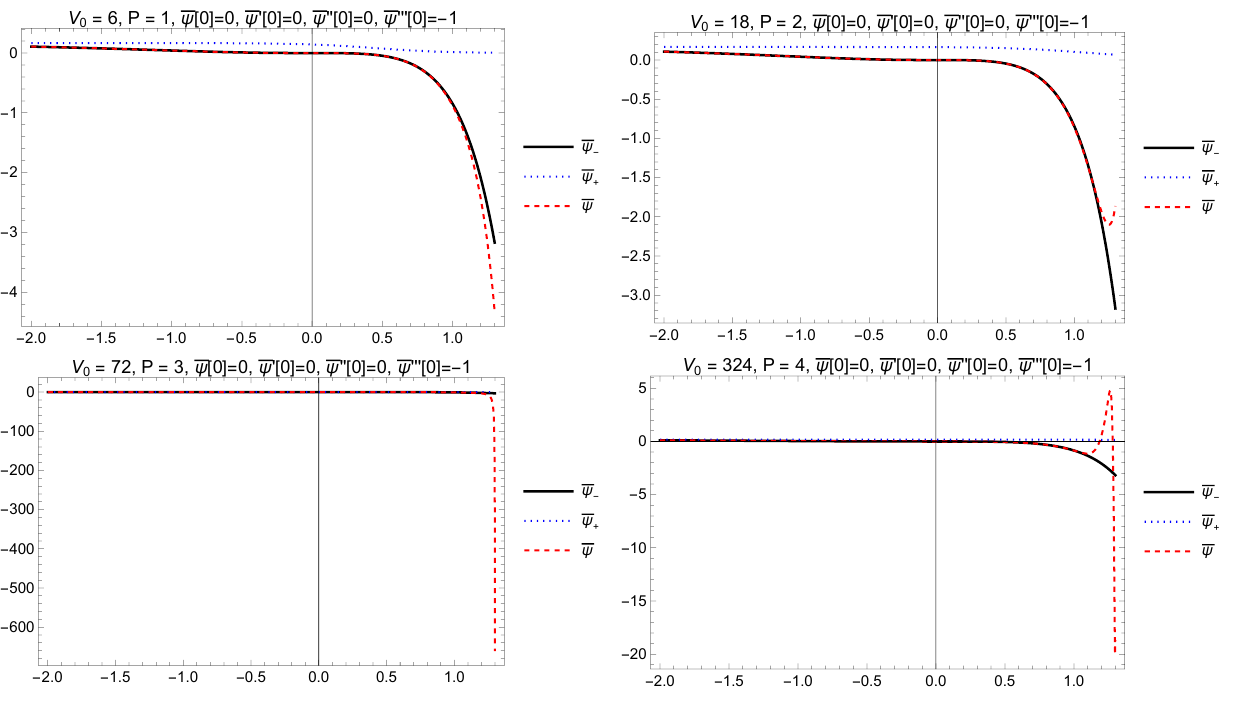
Figure 1. Comparison of exact solution ¯ ψ of (39) with initial conditions ¯ ψ ( 0 ) = 0, ¯ ψ (cid:48) ( 0 ) = 0, ¯ ψ (cid:48)(cid:48) ( 0 ) = 0, ¯ ψ ( 3 ) ( 0 ) = − 1 and the asymptotic solutions ¯ ψ ± for V 0 = 6 P / P , P >